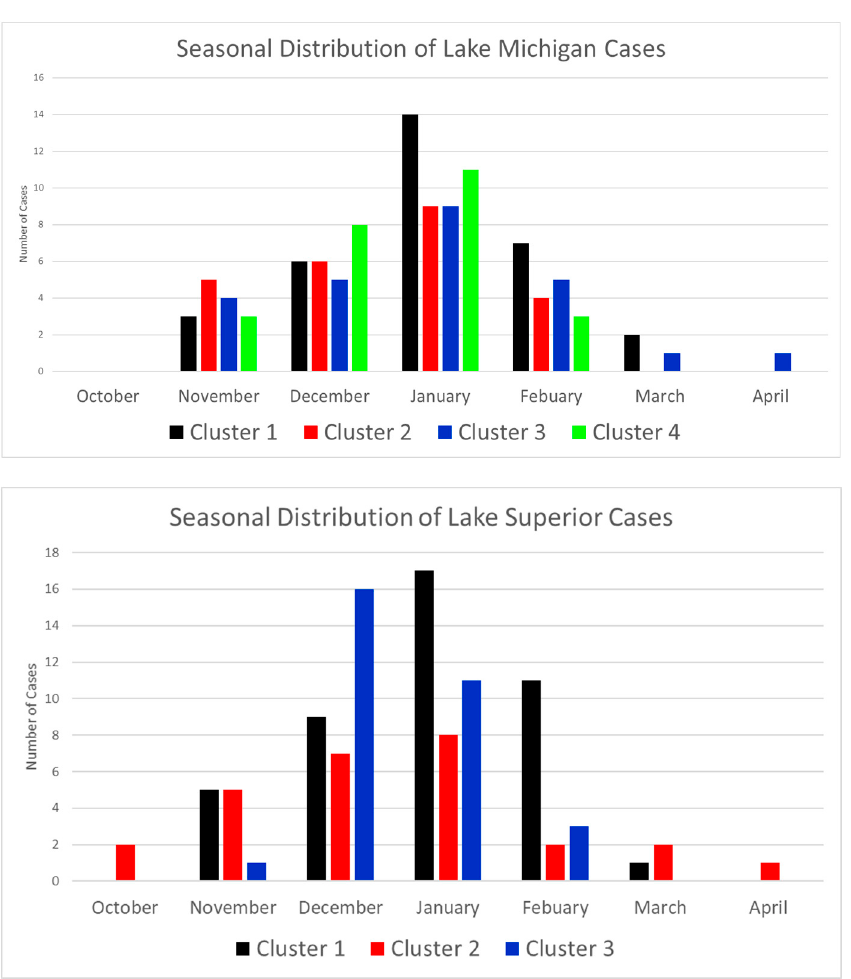
Figure 4 . Scatterplot of the first two PC loading vectors for Lake Michigan (left) and Lake Superior (right).